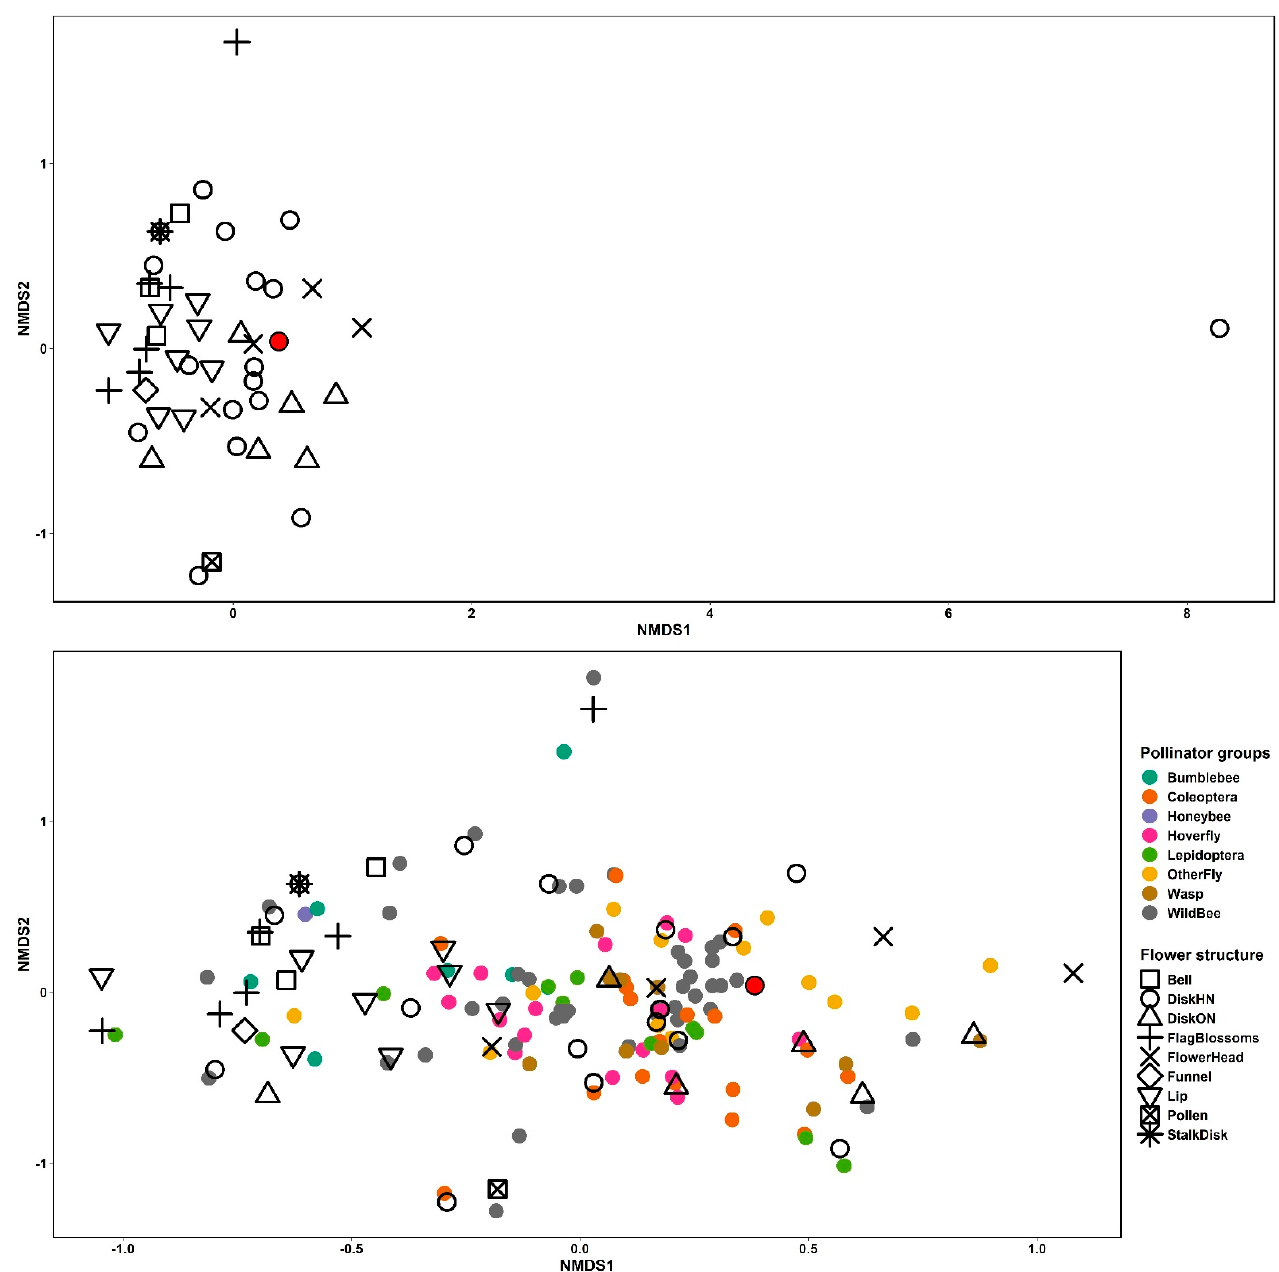
Figure 2. Non-metric multidimensional scaling (NMDS) plot based on the Bray-Curtis dissimilarity distance of insect visitations on plant species ( top ). Bottom is a close-up of ordination with the removal of the outlier, plus the visualization of pollinator species. OSR is highlighted in red. Different functional groups of plants are symbols and pollinator groups are colors. Stress level = 0.13.